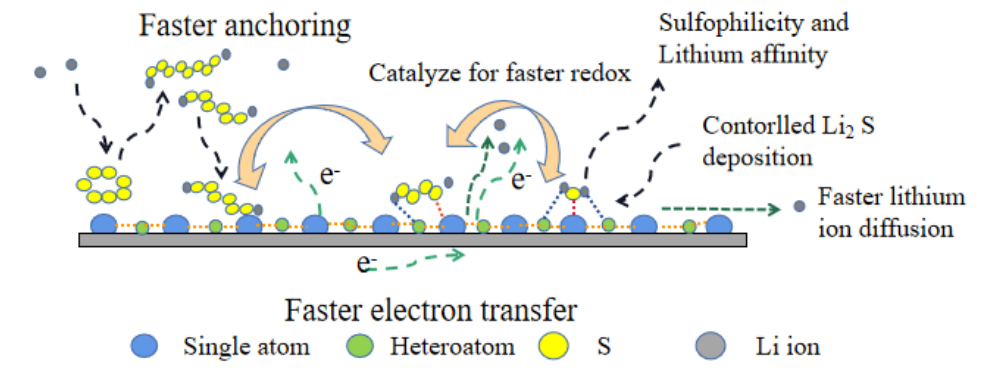
Figure 10. The next-generation catalyst material for LPSs.